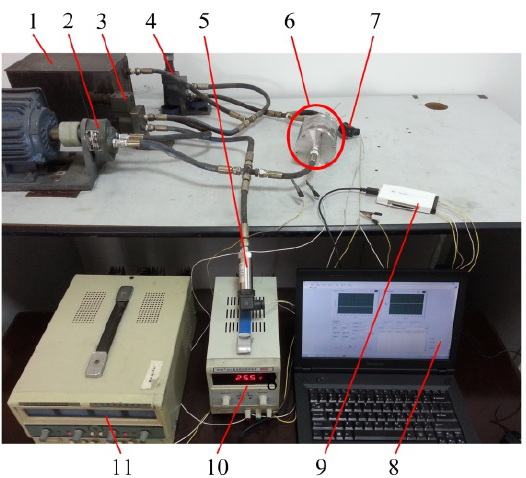
Figure 21. Experimental test system of the radial MR valve. 1-MR fluid tank; 2-Gear pump; 3-Relief valve Ⅰ ; 4-Relief valve Ⅱ ; 5-Pressure sensor Ⅰ ; 6-MR valve; 7-Pressure sensor Ⅱ ; 8-Computer; 9-Acquisition card; 10-Power supply Ⅰ ; 11-Power supply Ⅱ .